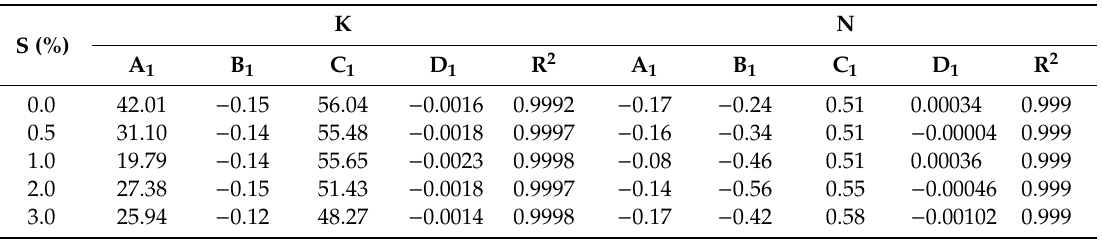
Table 10. Parameters of exponential functions that can reflect the relationship of K and N to FTC under di ff erent S.